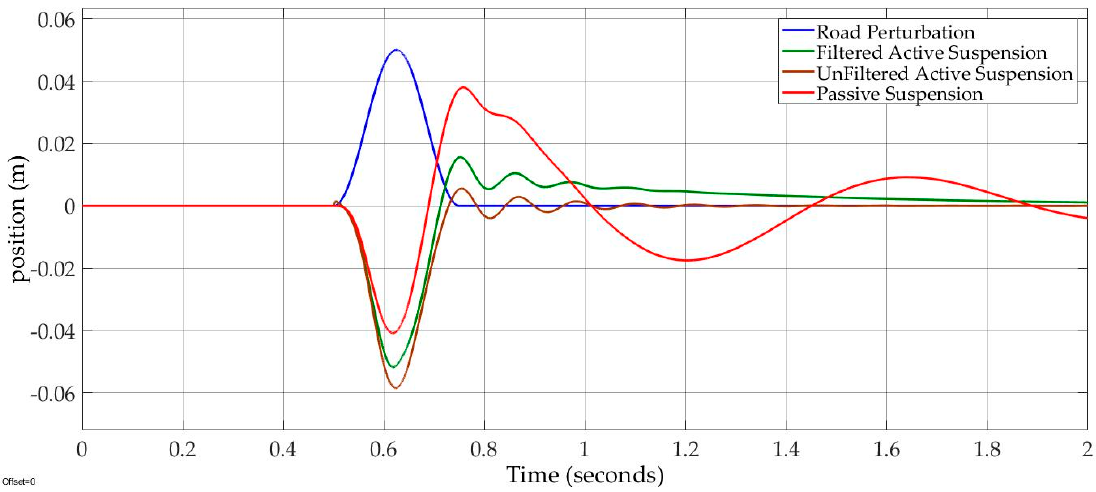
Figure 9. Suspension travel of Case 1.